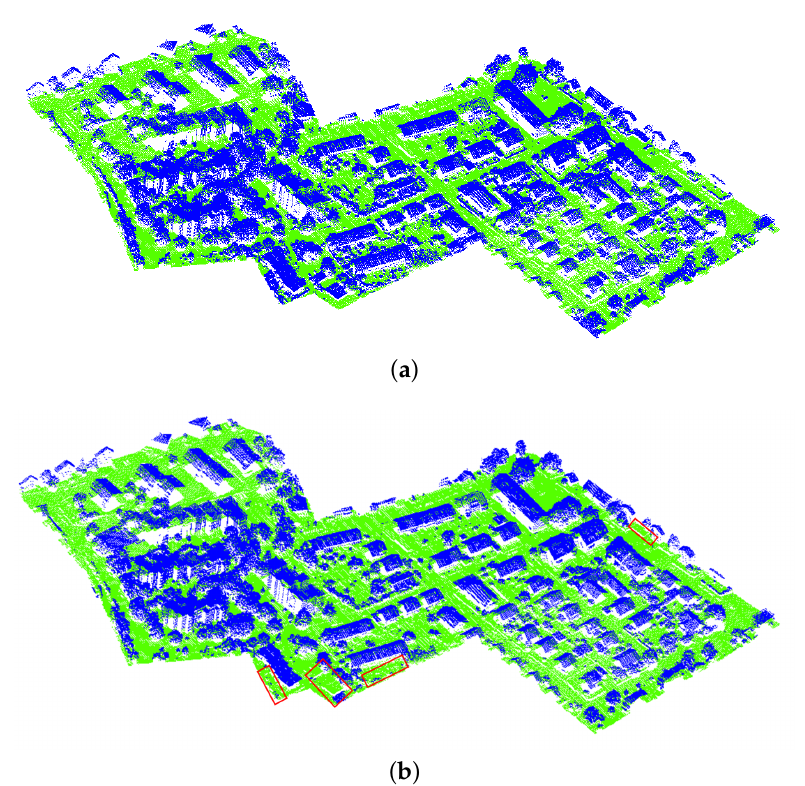
Figure 8. The result of the proposed method. ( a ) The point cloud manually labeled. ( b ) The point cloud processed by the proposed method. The red box area in ( b ) is classified